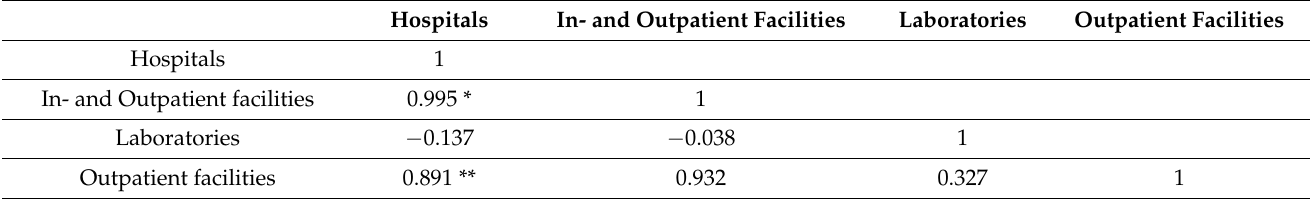
Table 6. Correlation matrix, South-East Africa.